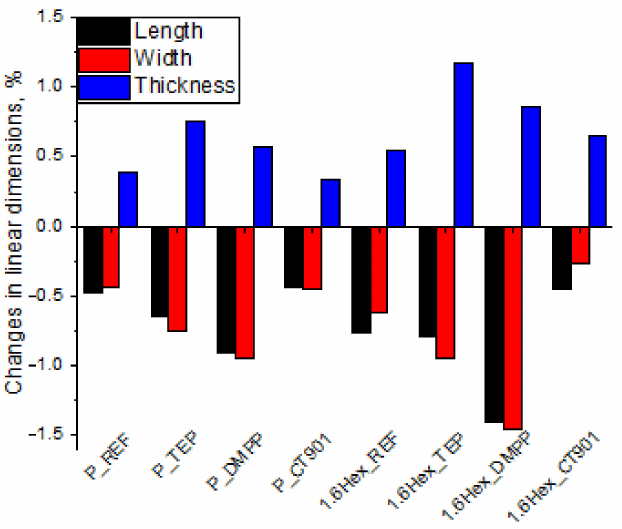
Figure 6. Changes in linear dimensions of RPURFs after seasoning at − 25 ◦ C for 24 h.